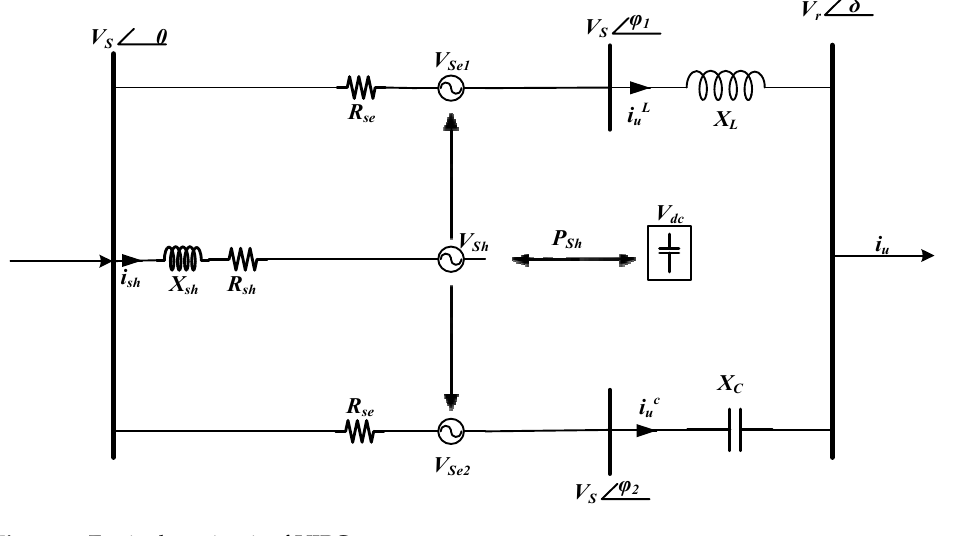
Figure 2. Equivalent circuit of UIPC.